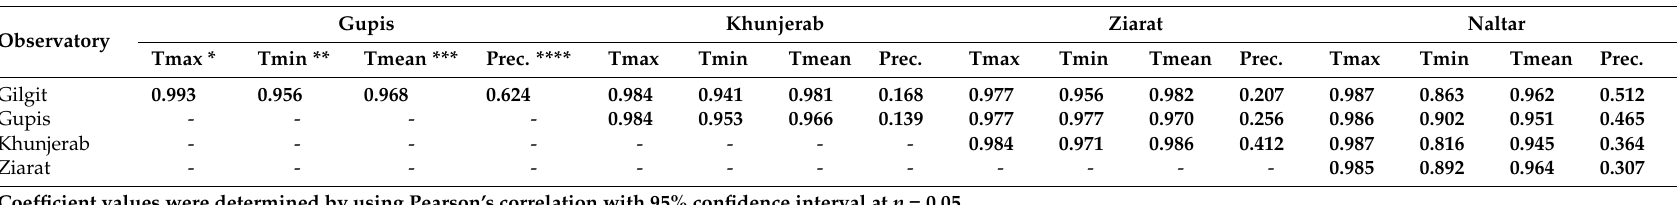
Table 1. Pearson correlation coefficients for observed monthly temperature and precipitation among the climate observatories for the period 1995–2013.